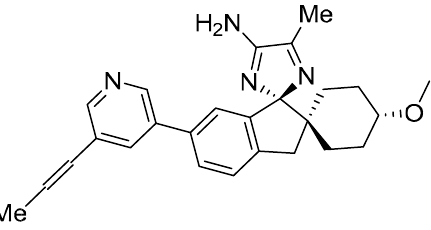
Figure 34. AZD3293 (LY3314814, lanabecestat, 43 ) from AstraZeneca.